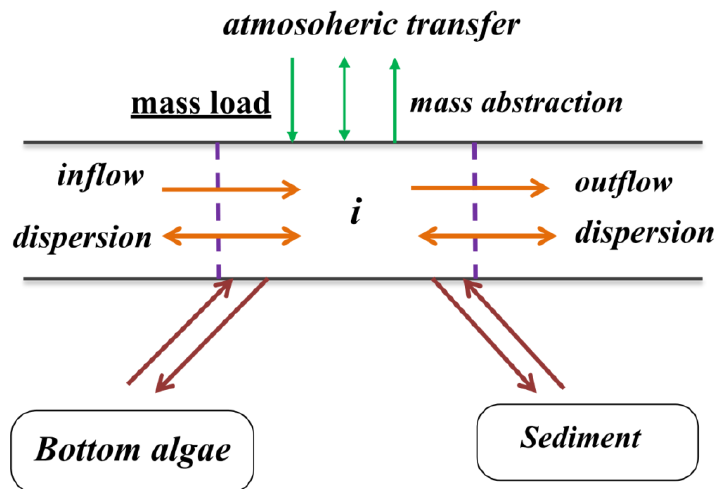
Figure 4. Temperature balance for the first river section.